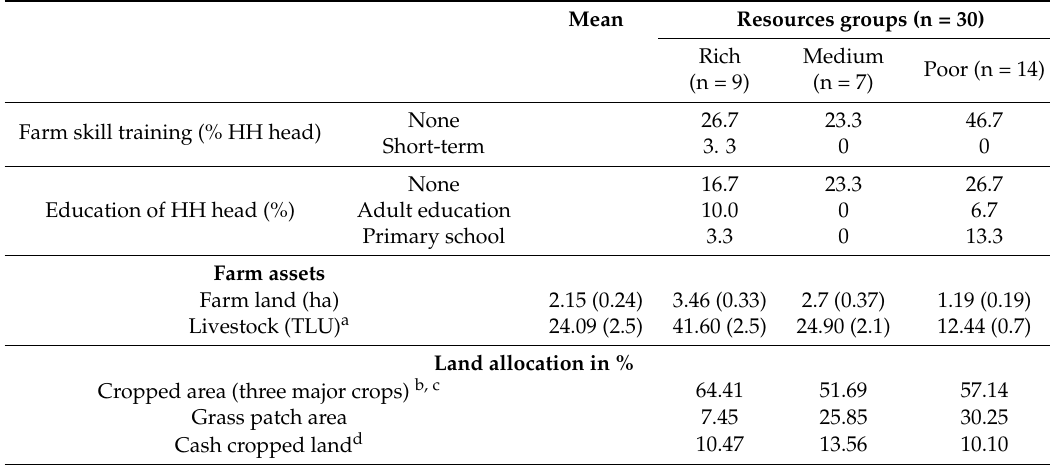
Table 1a. Farm characteristics in Borana, southern Ethiopia.